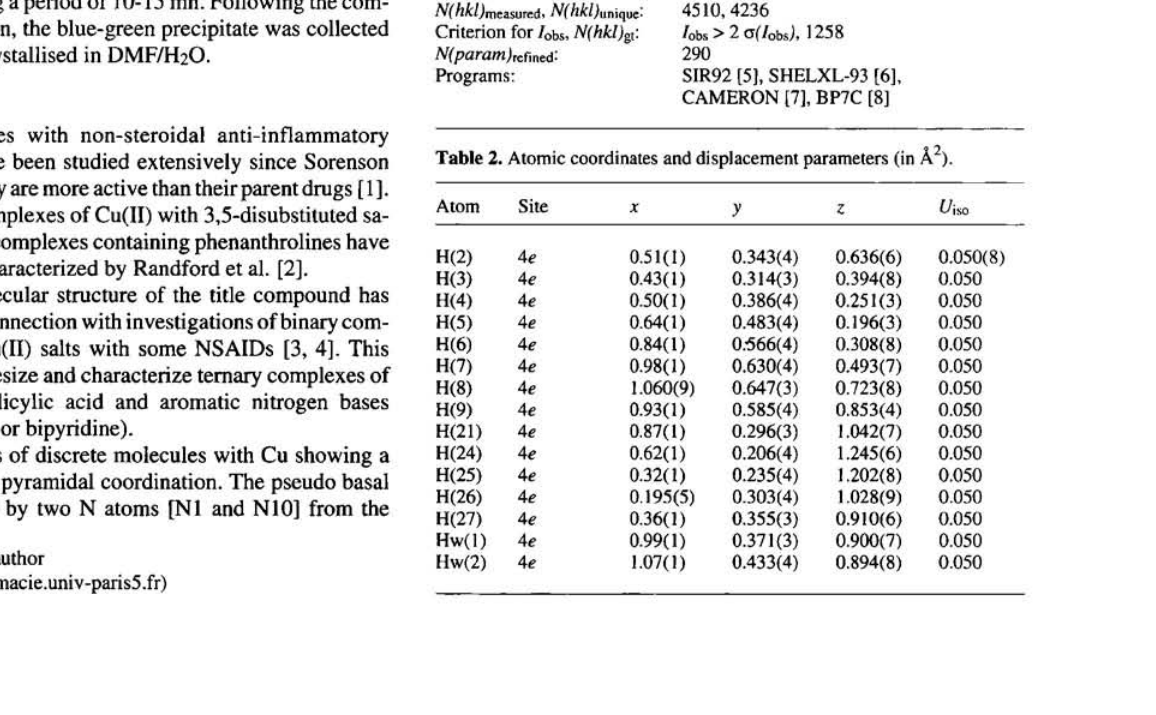
Table 2. Atomic coordinates and displacement parameters (in À